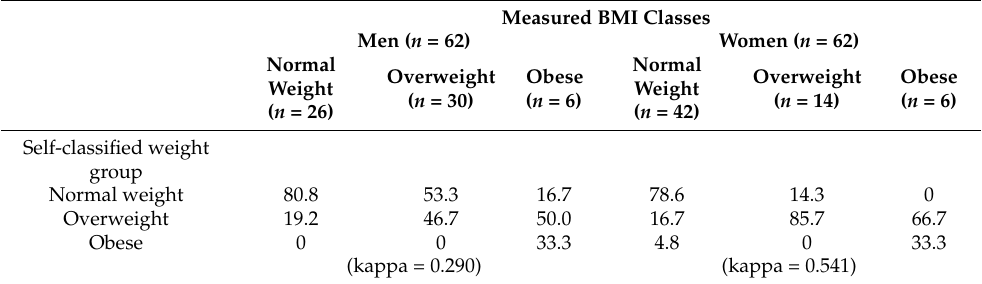
Table 4. Percentage distribution (%) of measured BMI ** (kg/m 2 ) and self-classified weight group *.